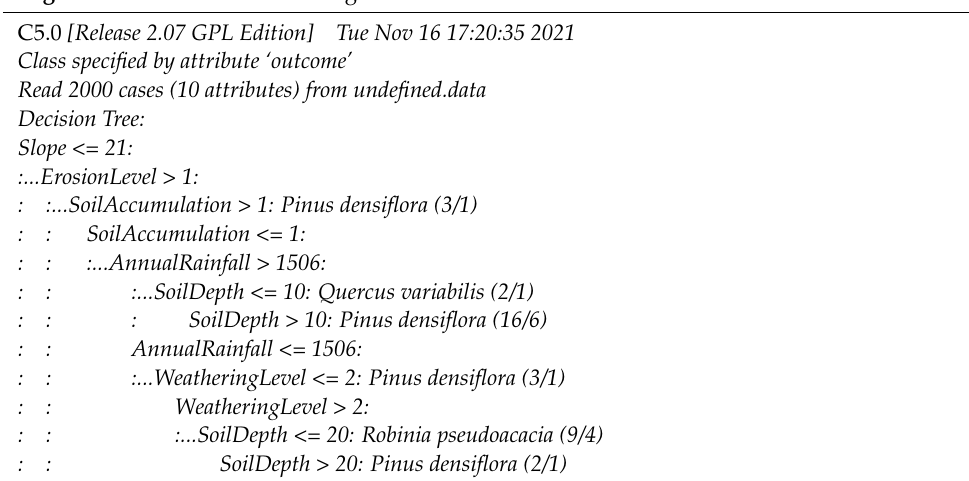
Algorithm 1 Result of C5.0 DT